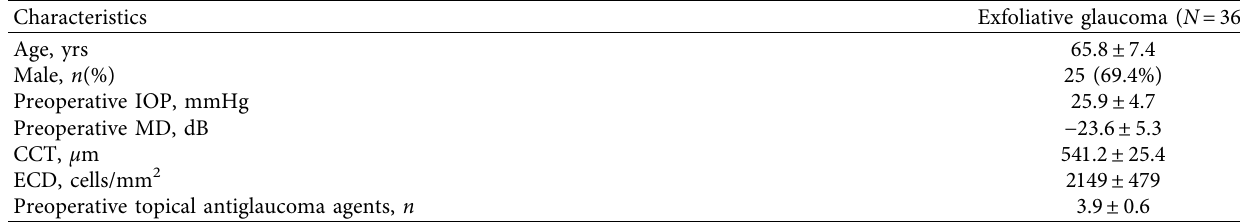
Table 1: Clinical and demographic data of the patients.